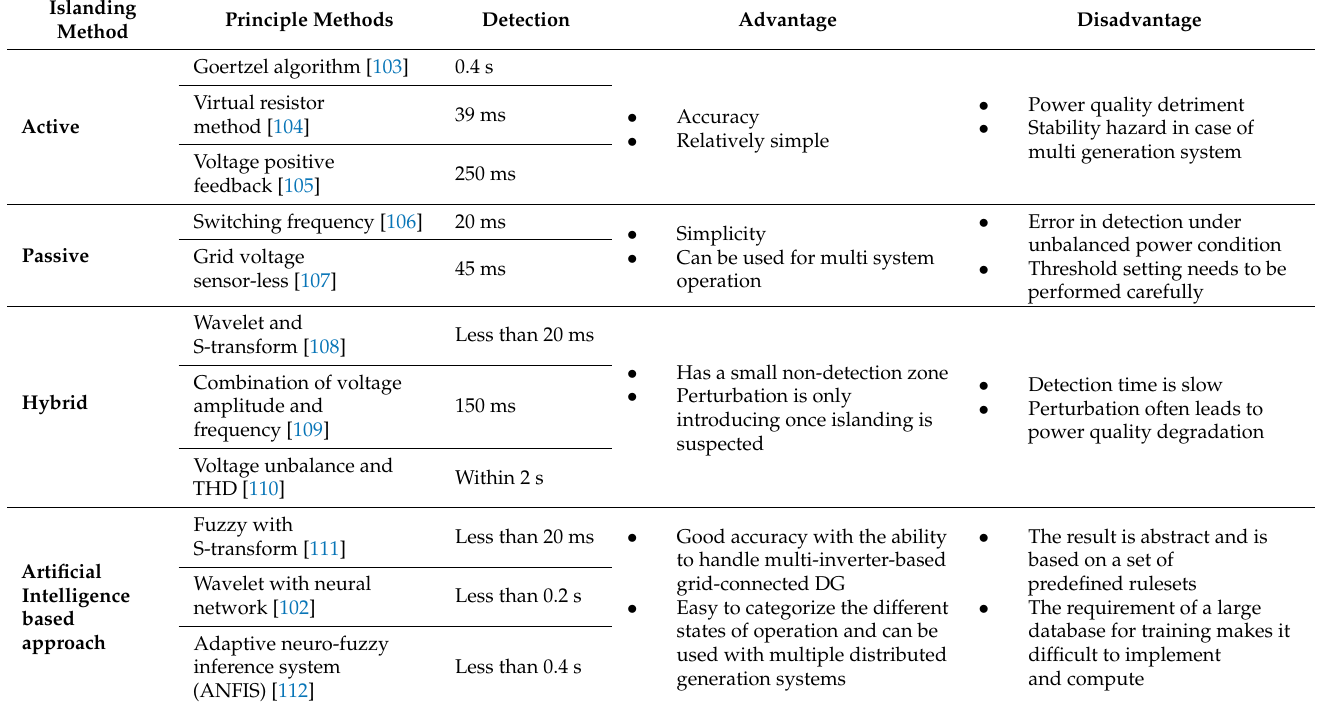
Table 6. Comparison of islanding detection